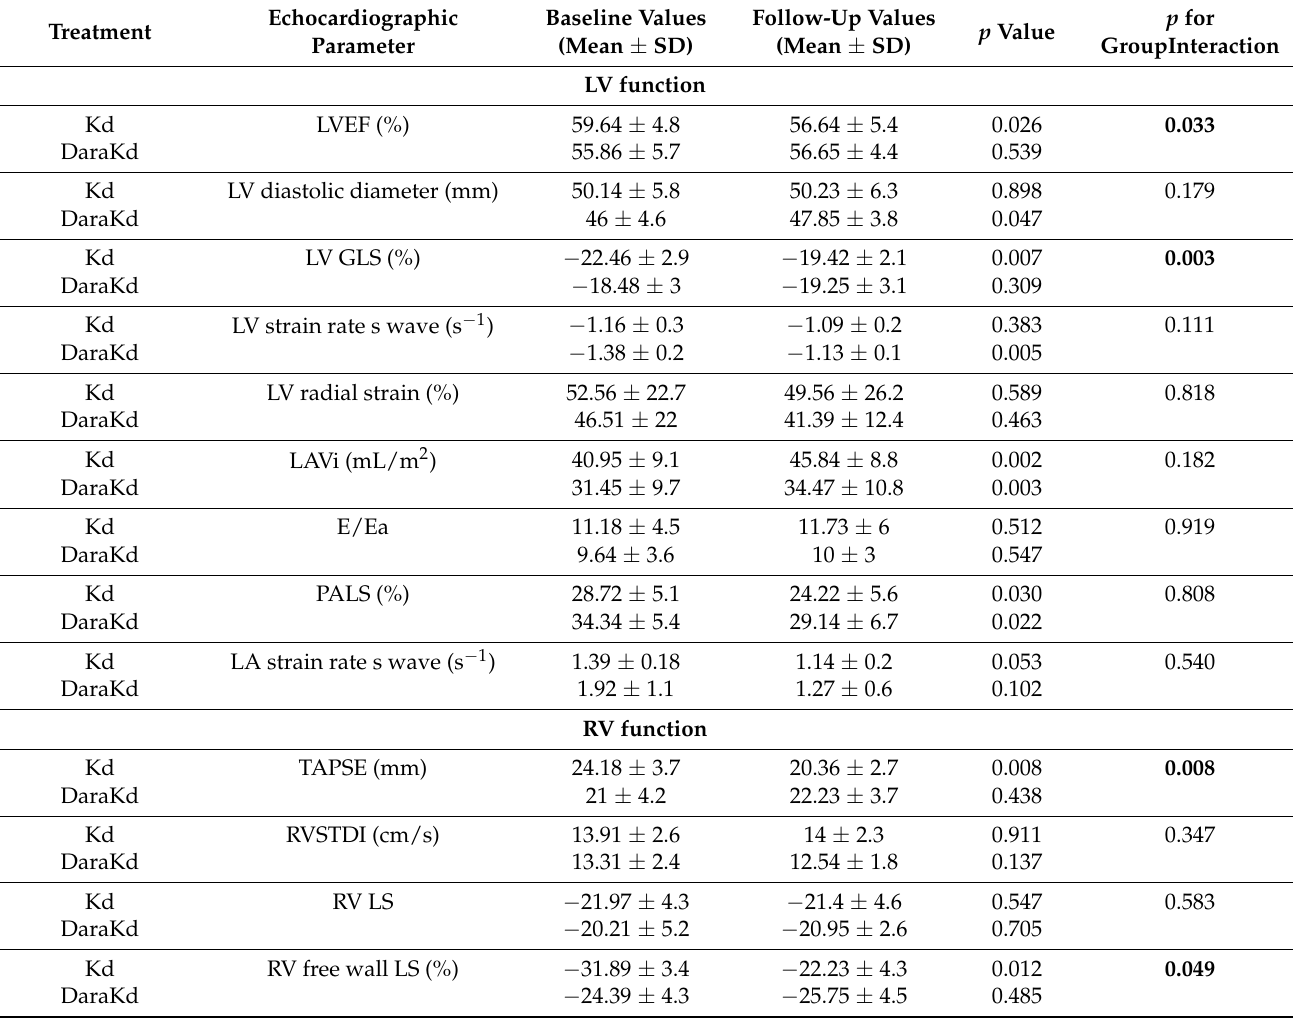
Table 2. Changes in echocardiographic markers according to treatment